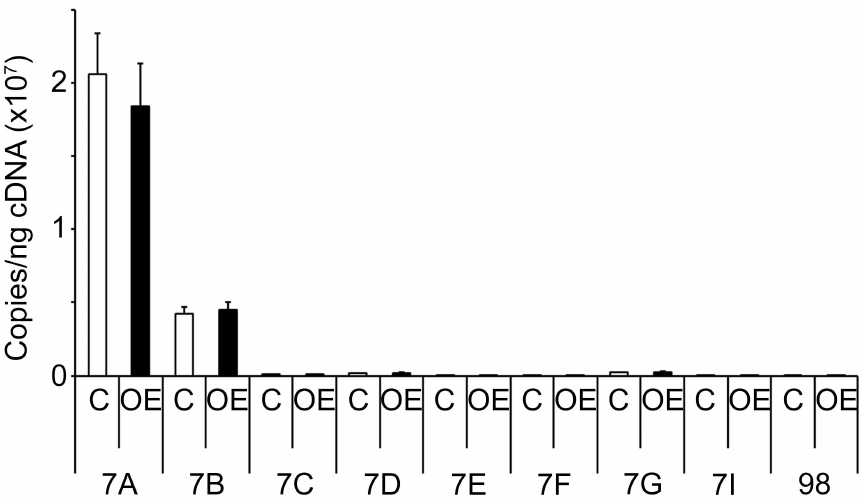
Fig 4. HMGA2 does not regulate the let-7 family of miRNAs. Effects in the expressionlevels of the let-7 family of miRNAs were analyzedin HMGA2-OE and empty vector control transductions. Quantitationof copy numberper nanogramcDNA (copies/ngcDNA) by Q-RT-PCR analyseswas performed at culture day 14. Open bars represent empty vector control and black bars represent HMGA2-OE. Mean value ± SD of four independent donors for each condition. C = empty vector control transduction; OE = HMGA2